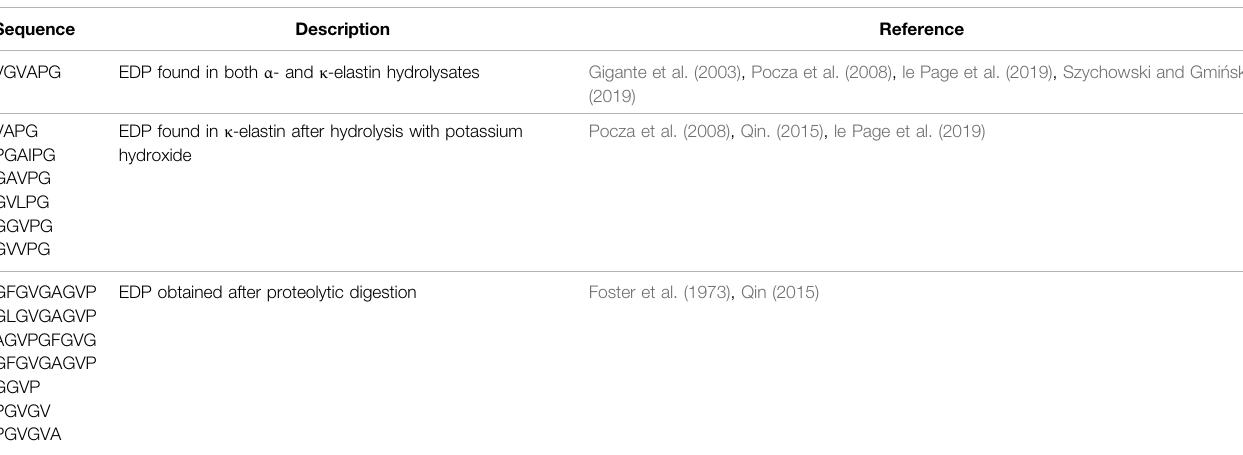
TABLE 1 | Examples of some elastin-derived peptide (EDP) sequences obtained by hydrolysis or proteolytic digestion. Sequence